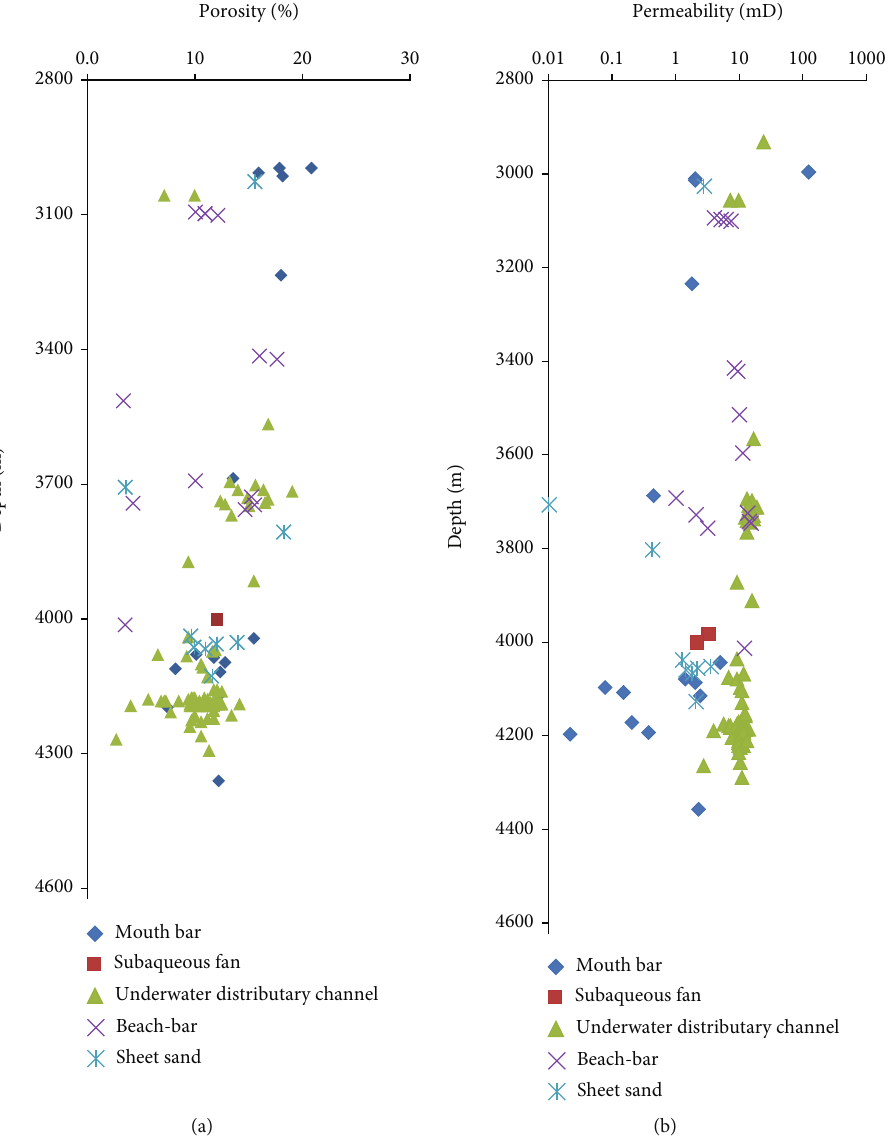
Figure 9: The vertical distribution of porosity (a) and permeability (b) of di ff erent depositional facies